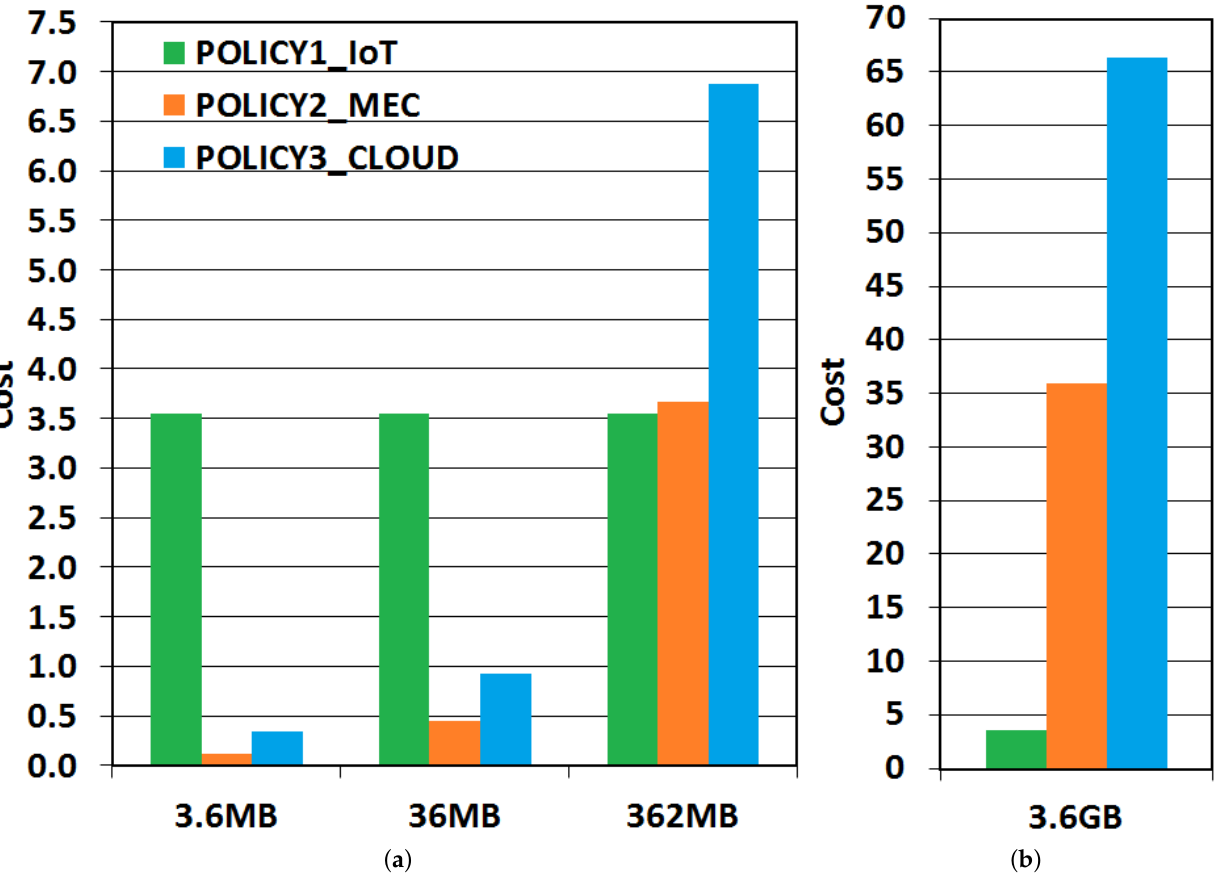
Figure 5. Cost policies for input data size variation in Application 1. ( a ) Cases A, B and C. ( b ) Case